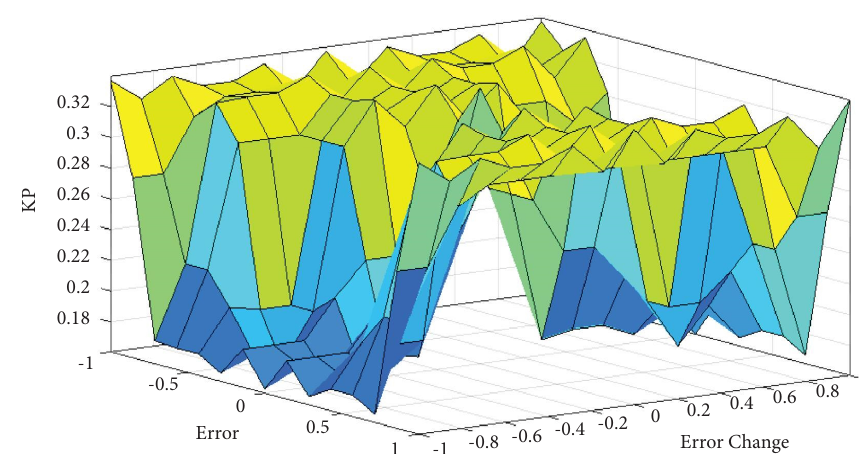
Figure 13: Outputs Δ K